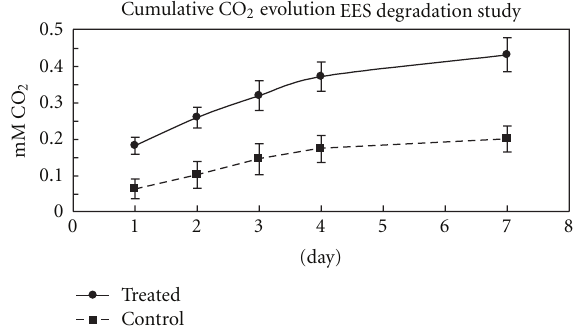
Figure 4: Evolution of CO 2 during the incubation period of the soil degradation study, which assessed the degradative ability of the EES applied to pesticide-contaminated soil. Cumulative evolution of CO 2 in treated and control biometers. Values are the average of 9 samples. Error bars represent 1 standard